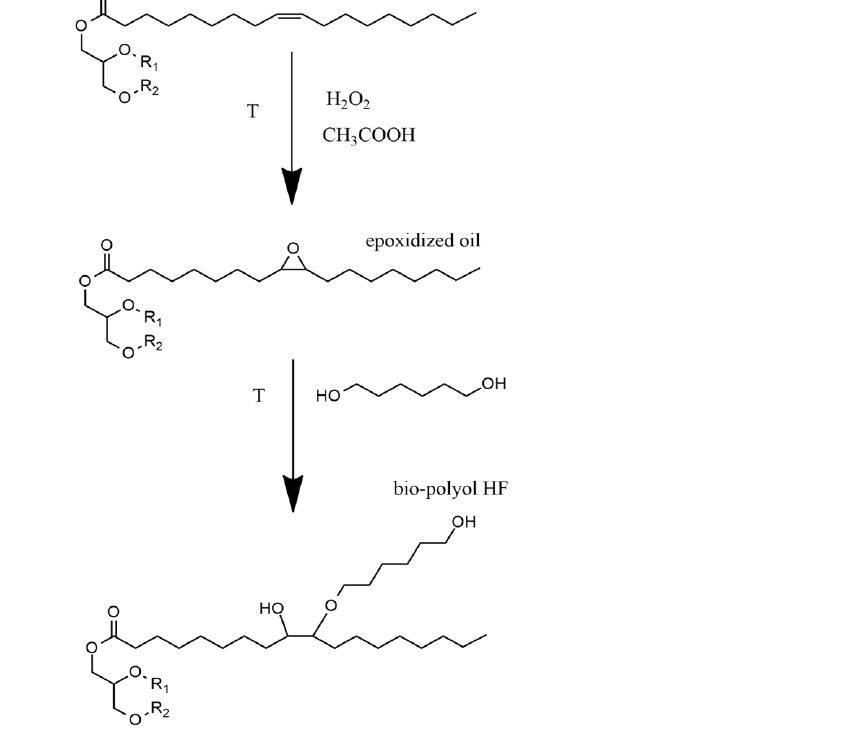
Figure 6. Scheme of epoxidation and opening of oxirane rings with 1.6-heksanediol (T = 80–90 °C). Table 3. Characteristics of RF551 and bio-polyol